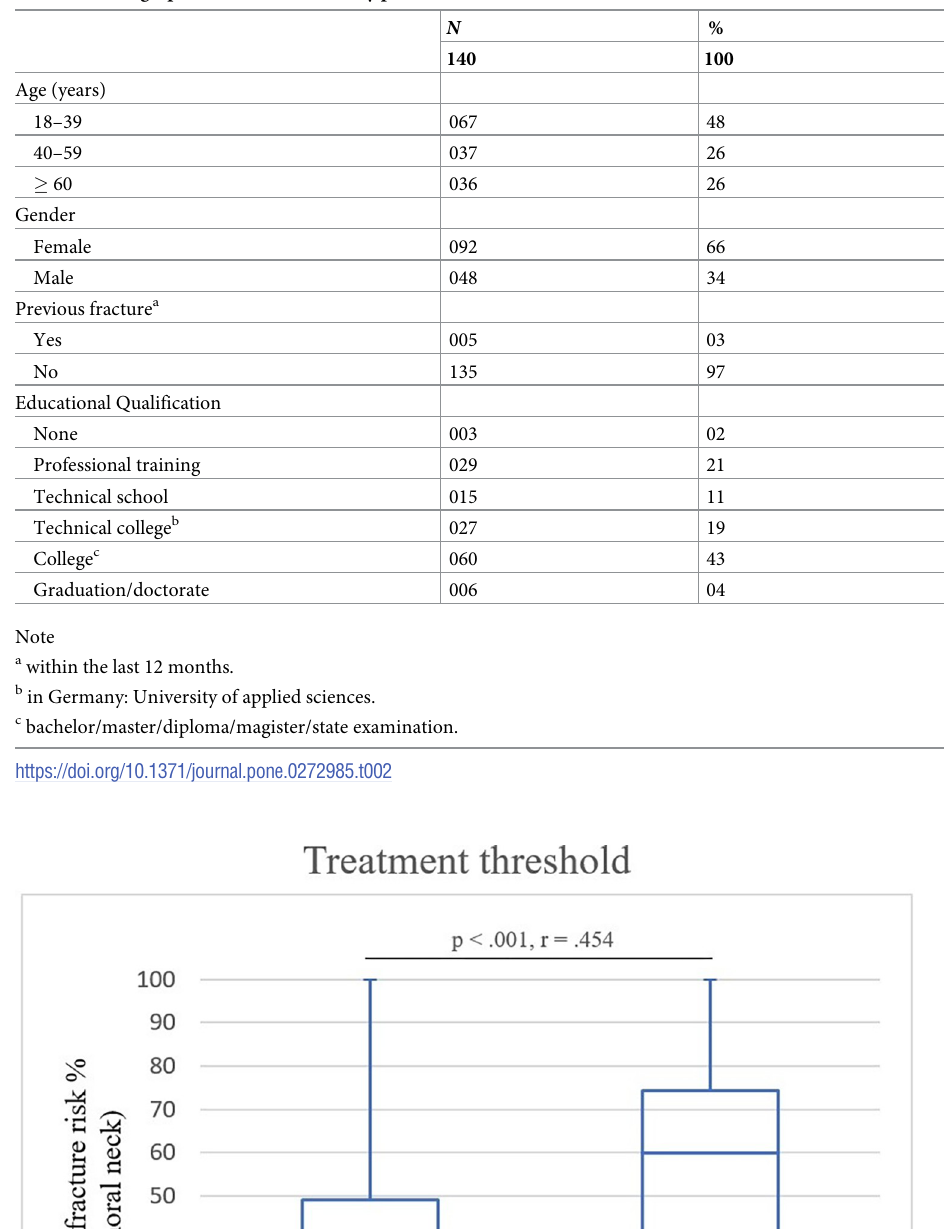
Table 2. Demographic characteristics of lay persons.